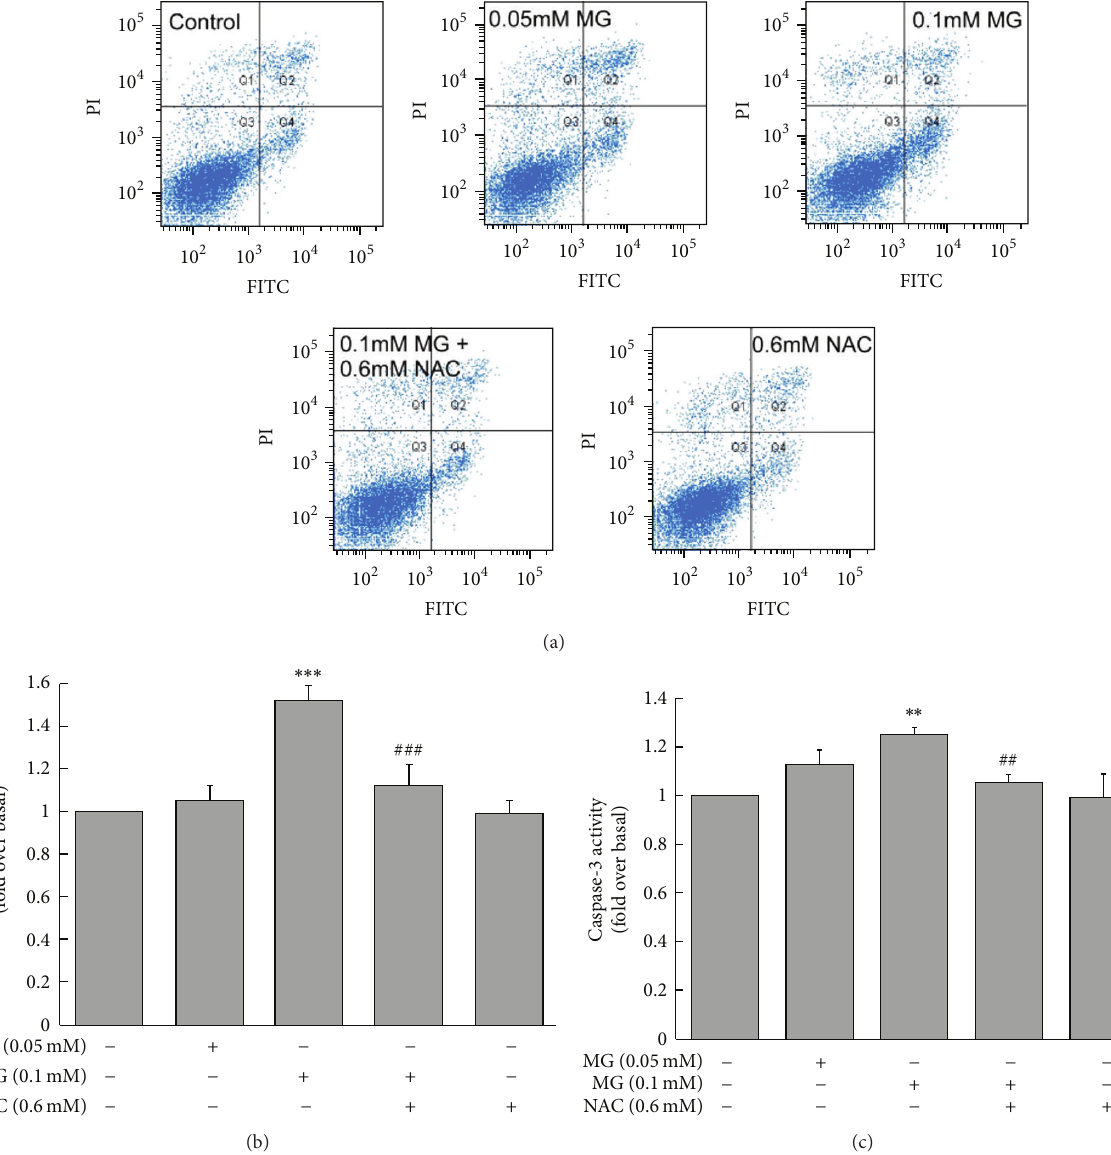
Figure 2: Effects of MG on MIN6 cell apoptosis. Apoptotic rate was higher in MG-treated MIN6 than in controls, and this effect was relieved by coculturing with NAC. (a) Apoptosis was measured by Annexin V-FITC/PI assay, and FITC-positive but PI-negative cells were quantified by flow cytometer. (b) Statistical results of (a). (c) Caspase-3 activity. ∗∗ 𝑝 < 0.01 , ∗∗∗ 𝑝 < 0.001 compared to control group (0mM MG